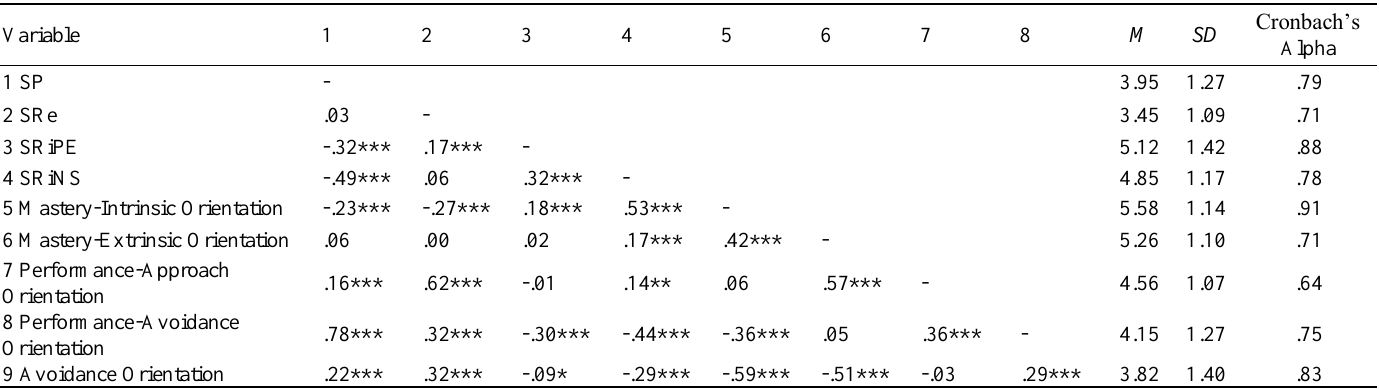
Factor Correlations for Latent Variables, and Descriptive Statistics and Cronbach’s Alphas from Composite Scores (Study